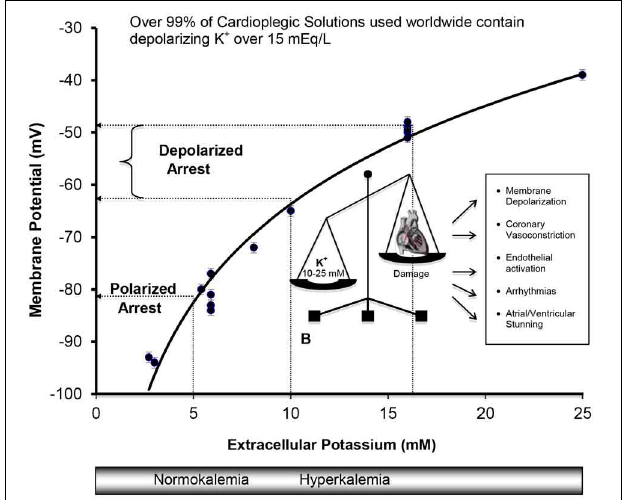
FIGURE 3 | Cell Membranes of the Atria, Purkinje, and Ventricular Myocytes in vivo behave as a K + electrode over a range of extracellular K + from 3 to 25mM. Data were obtained from isolated rat, rabbit, and guinea-pig hearts (Kleber, 1983; Masuda et al., 1990; Sloots and Dobson, 2010; Dobson and Jones, 2004; Dobson, 2010) and from isolated cells (Wan et al., 2000). The membrane potential ϕ (mV) = 27 ln [K + ] − 126, R 2 = 0 . 97, where [K + ] is extracellular potassium concentration in mM. Membrane potentials ( ϕ ) were measured directly using potassium microelectrodes (Kleber, 1983; Masuda et al., 1990; Snabaitis et al., 1997; Wan et al., 2000) or calculated from Nerstian distributions of potassium (Dobson and Jones, 2004; Sloots and Dobson, 2010). The relation between potassium and membrane potential for ventricular muscle also agree well with microelectrode measurements on isolated human atrial muscle (Gelband et al., 1972), and for isolated purkinje fibers above 5.4mM K + bathed in Tyrode’s solution (Sheu et al.,